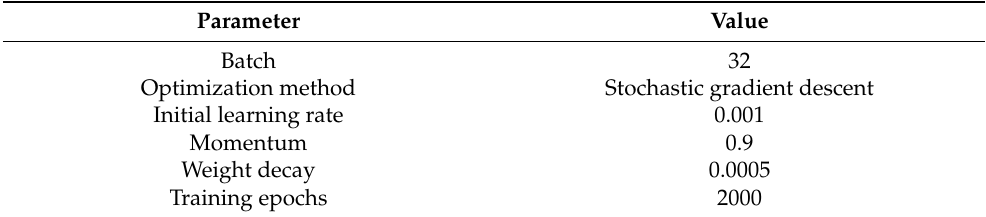
Table 1. Network training parameters.